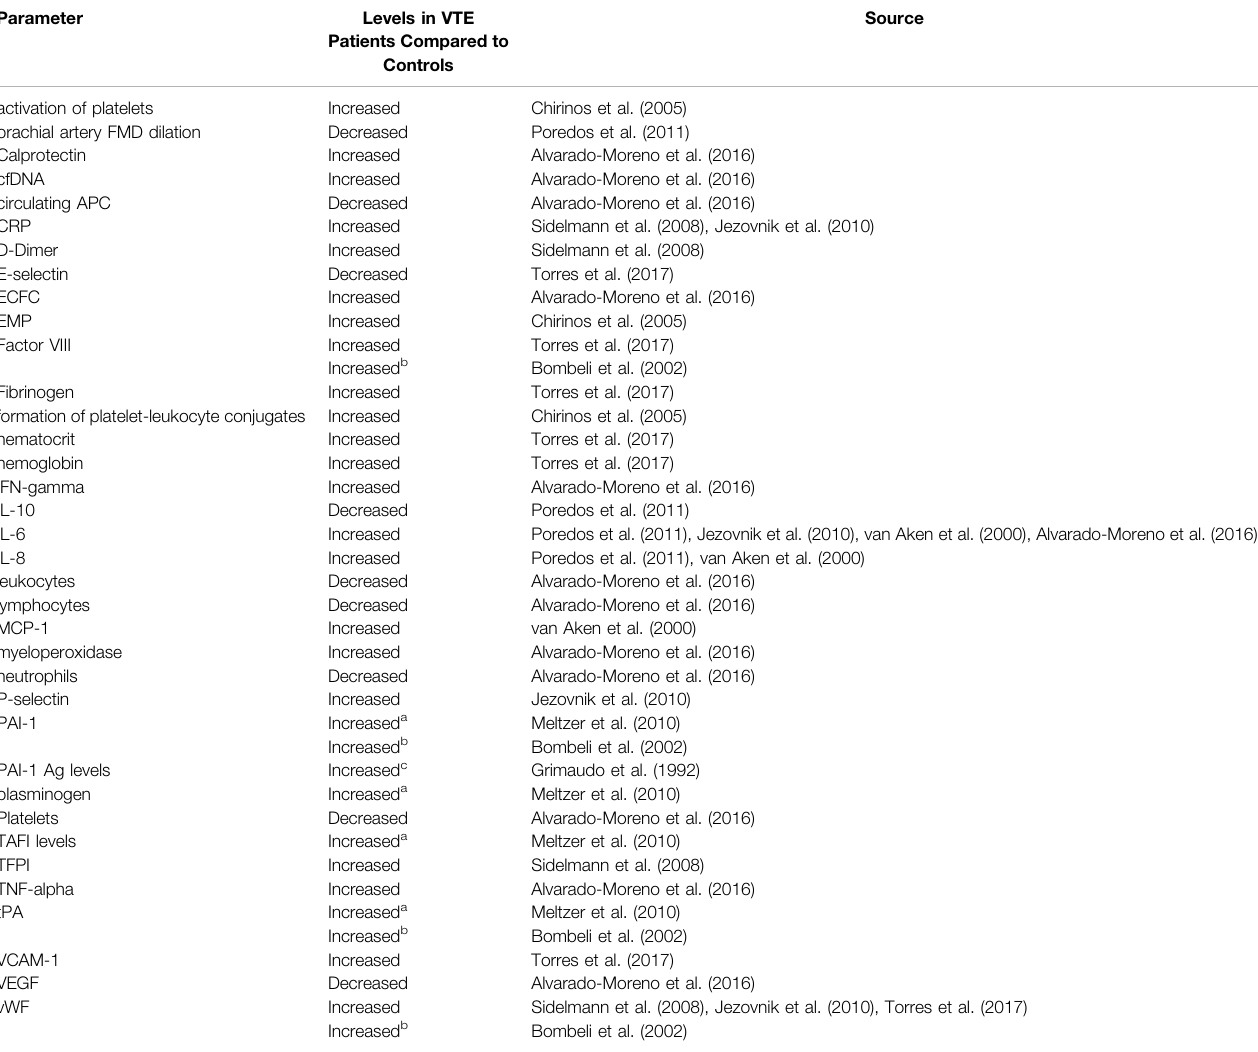
TABLE 4 | Levels of various biomarkers in VTE patients versus healthy controls.